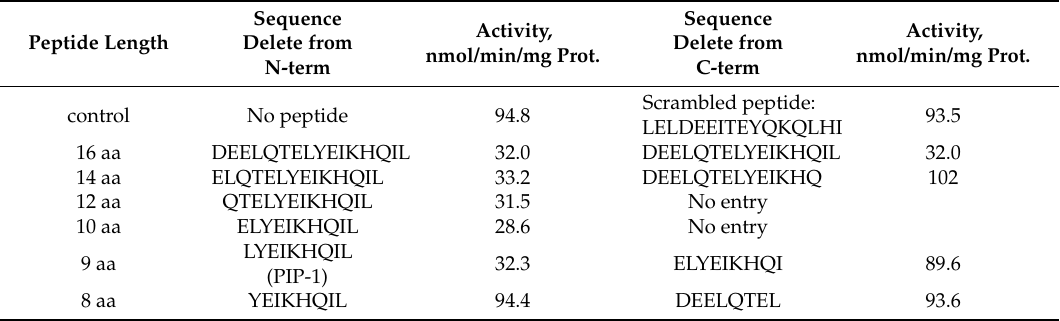
Table 1. Deletion of N- or C-terminal amino acids from 16-aa rat-derived SP-A peptide: effect on the inhibition of the aiPLA 2 activity of recombinant